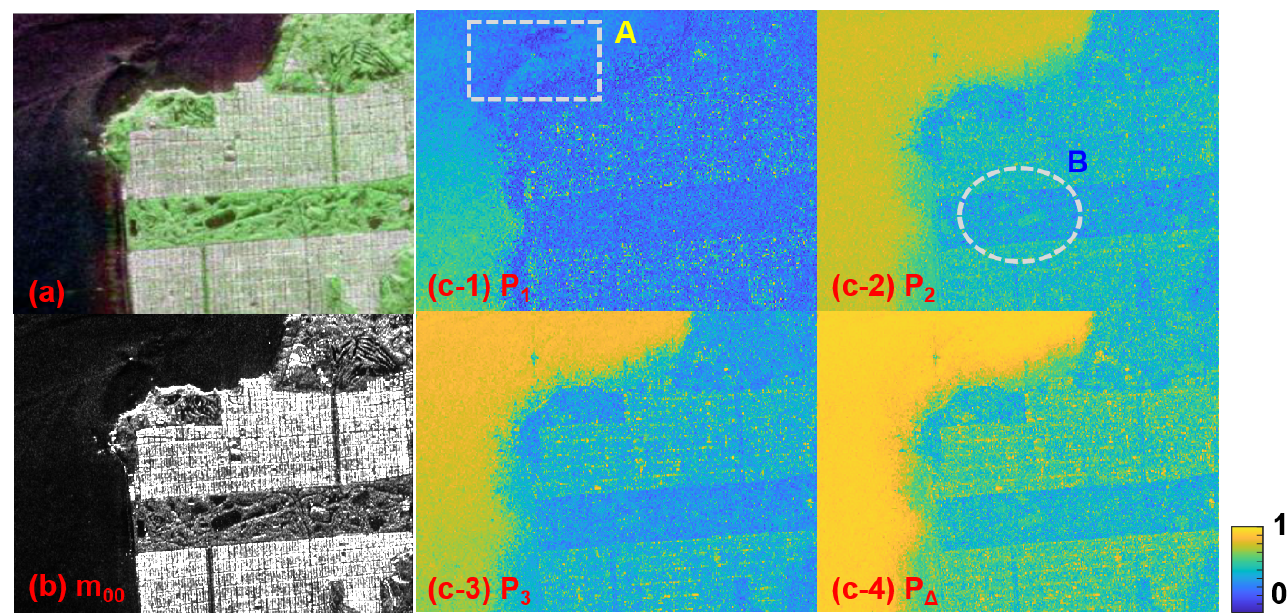
Figure 11. San Francisco Bay area ( a ) lexicographic color-coded PolSAR image ( | VV | , | HV | ,